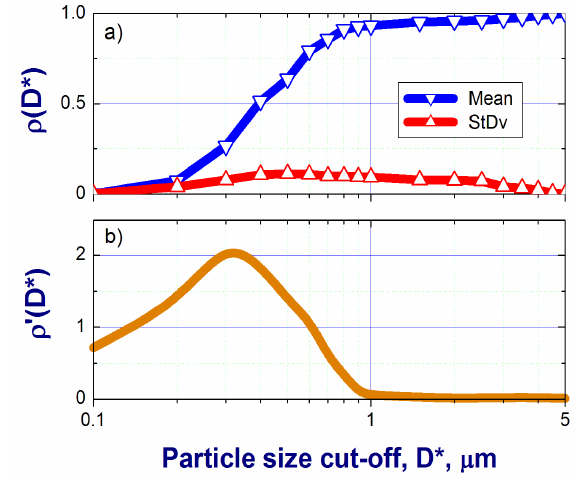
Figure B1. The normalized scattering coefficient ( a ) and its derivative ( b ) as a function of particle size cut-off. The blue line shows the mean for all TCAP flight legs and the red line represents the corresponding standard